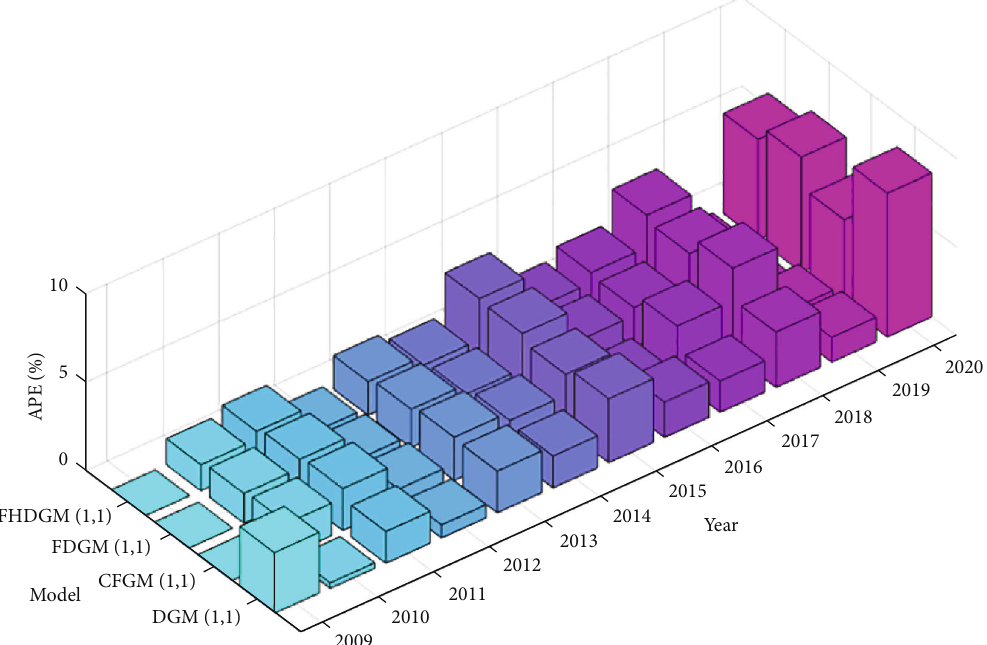
Figure 5: Fitted and predicted values of renewable energy consumption in the Asia Paci fi c region. Table 9: Optimal parameters of the three models with respect to renewable energy consumption in all of Europe. FHDGM (1,1) FDGM (1,1) CFGM (1,1) r 0.7230 r 0.3660 α 0.6288 MAPE (%) 1.90 MAPE (%) 1.74 MAPE (%)